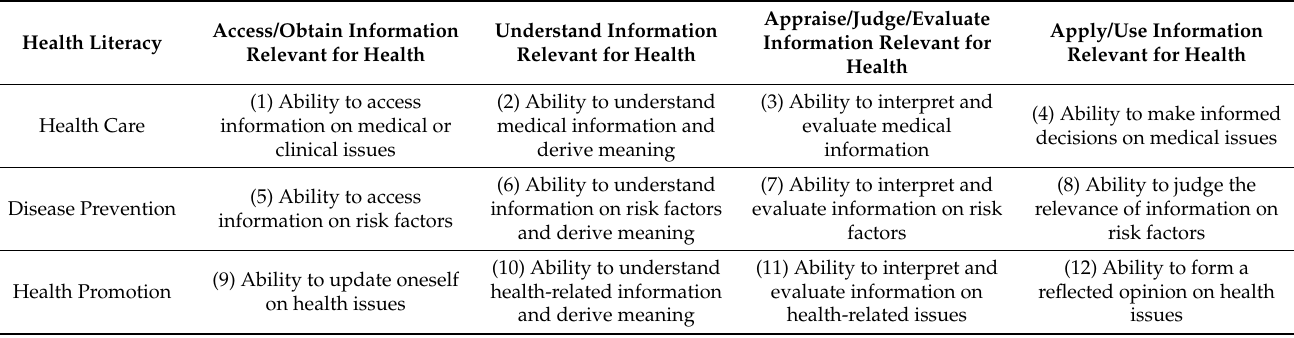
Table 1. Matrix of subdimensions of HL based on the HLS-EU Conceptual Model [8] used for developing the HLS 19